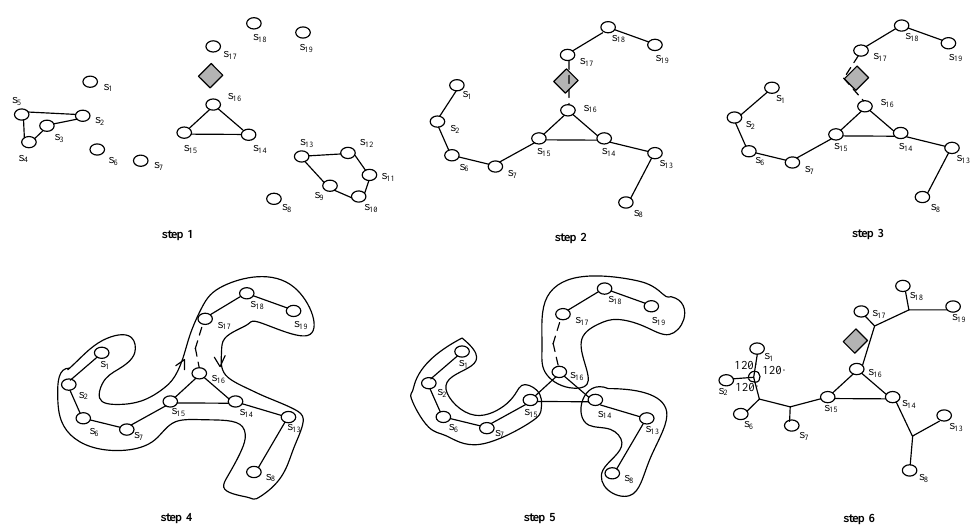
Figure 3. An example of Obstacle–Avoid connectivity restoration strategy based on Straight Skeletons